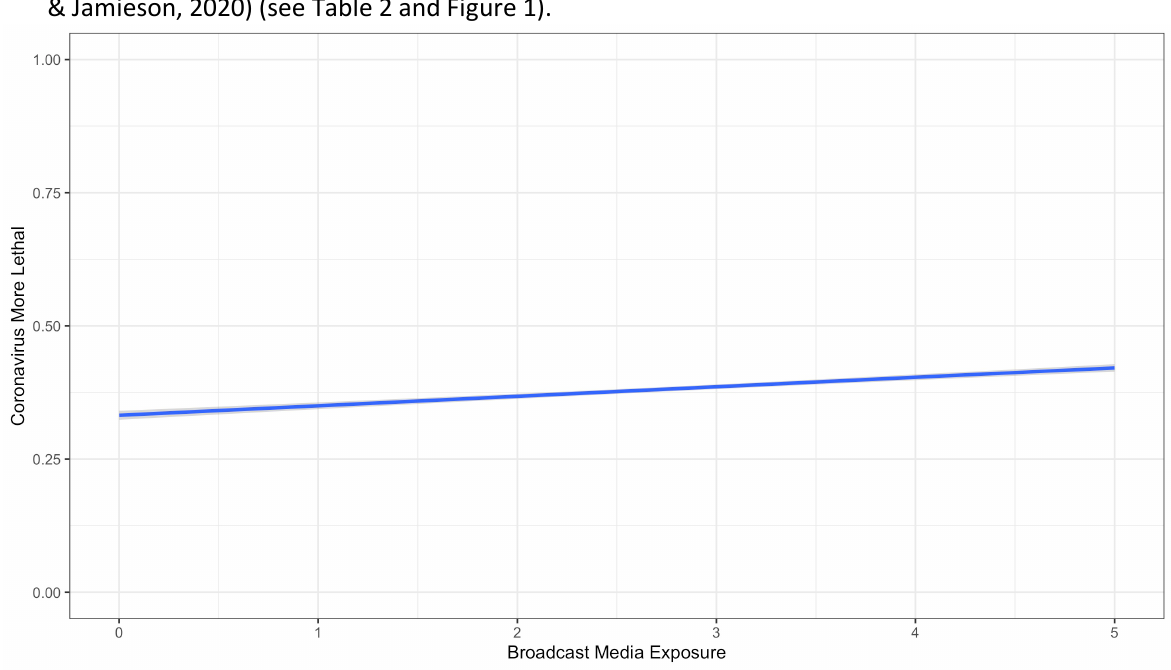
Figure 1. Association between Mainstream Broadcast Media Exposure and Perceived Lethality of